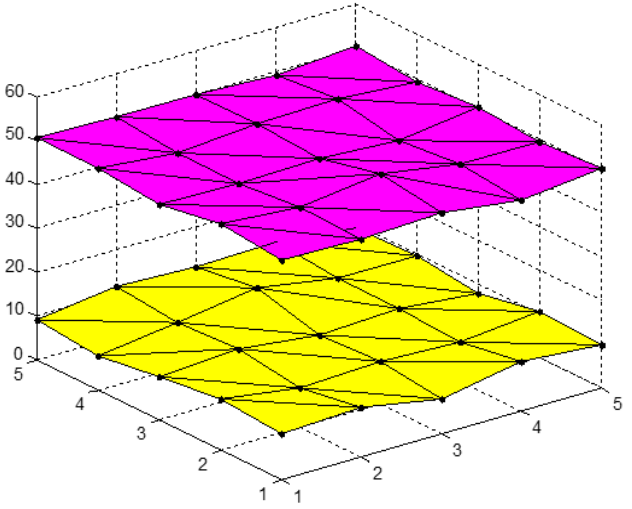
Figure 1. EGAR model panel data curved surfaces. The pink plane is generated by lining the panel data pots of research object and the yellow plane is generated by lining the panel data pots of another research object with one style.